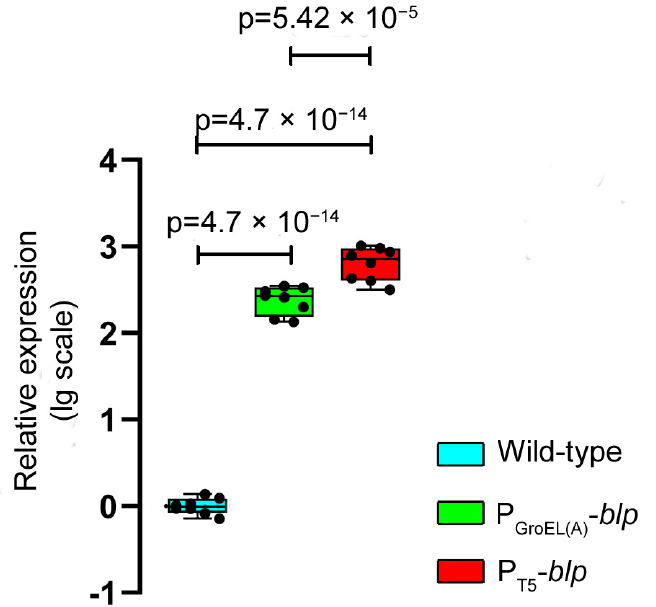
Figure 2. Relative level of expression of the blp gene in L. capsici strains. The boxplots show the median and IQR. The values were obtained in four independent experiments, each with two technical replicates. Statistical analysis was performed using a one-way ANOVA with Tukey’s multiple comparison test, p < 1 × 10 − 15 , F (2, 21) = 769.